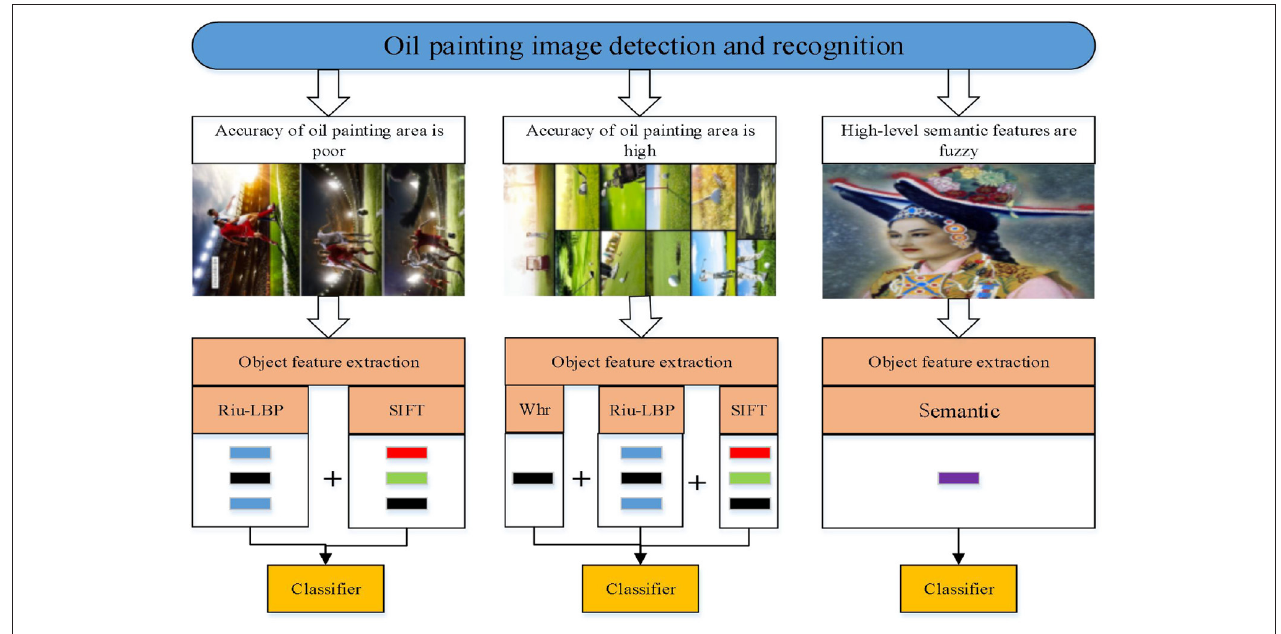
FIGURE 3 | Feature extraction and classification for oil painting image.